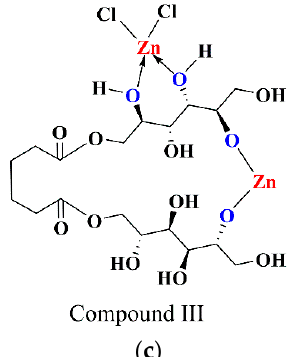
Scheme 2. The schematic diagram of DMAE-Zn to replace allyl chloride ( a ), to neutralize HCl ( b ), and to complex ZnCl 2 ( c ).